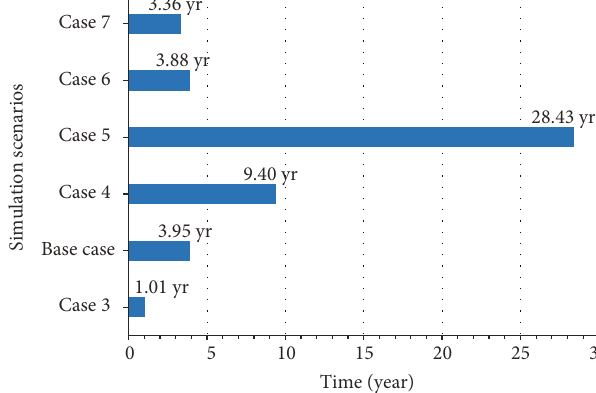
-EWR simulation 2